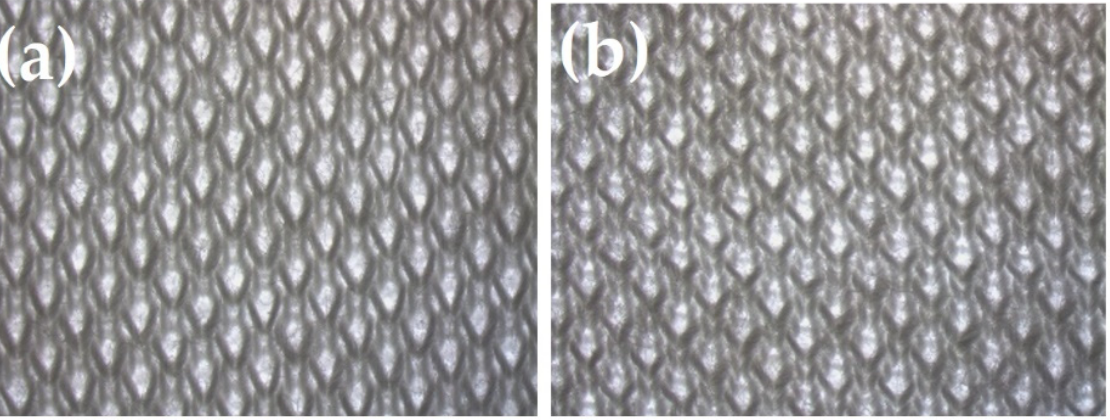
Figure 5. The right side of the spacer knitted fabric forming lining—I ( a ), left side of spacer knitted fabric forming lining—I ( b ), cross-sections of spacer knitted fabric forming lining—I ( c ). A cotton interlock knitted fabric with pique-type stitches was used for the layer adjacent to the spacer knitted fabric due to its strong hygroscopic properties and high absorbency, accompanied by strength (Figure 6).